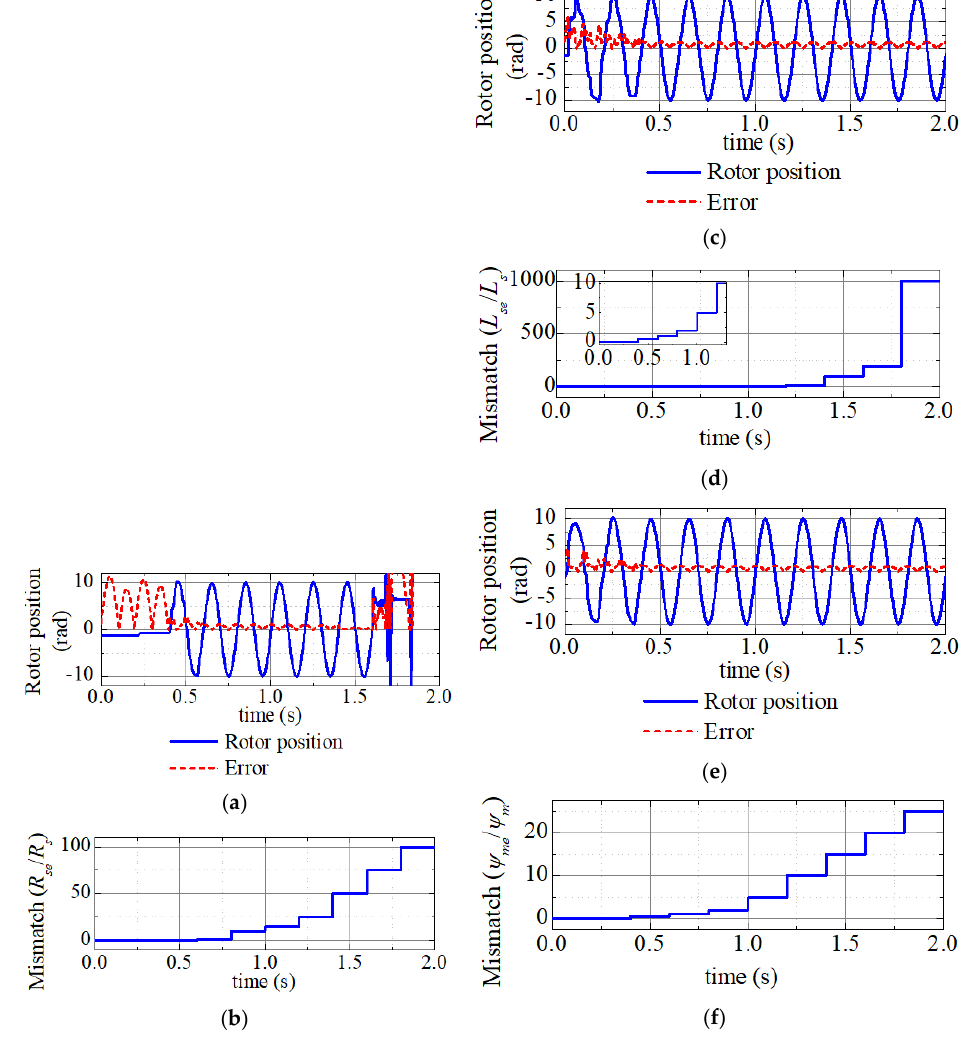
Figure 10. Parameter mismatches for the proposed method. ( a ) Rotor position and error with R se ; ( b ) different mismatch degrees for R se ; ( c ) Rotor position and error with L se ; ( d ) Different mismatch degrees for L se ; ( e ) Rotor position and error with ψ me ; ( f ) Different mismatch degrees for ψ me .